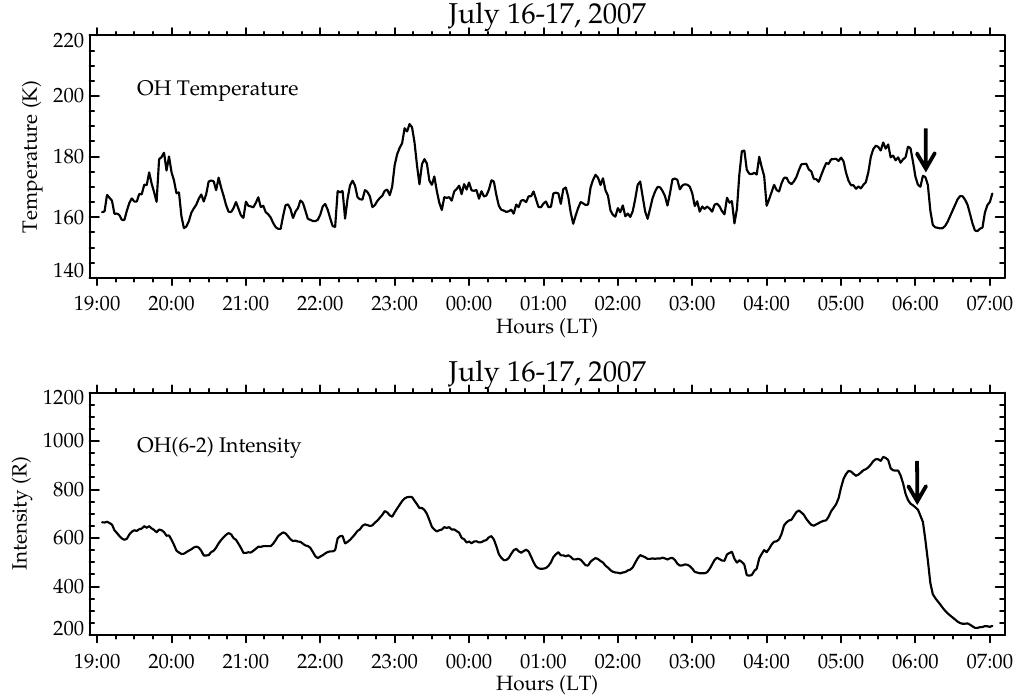
Fig. 8. Rotational temperature of the OH(6-2) emission and its band intensity, observed at Ferraz by an imaging spectrometer on 16–17 July